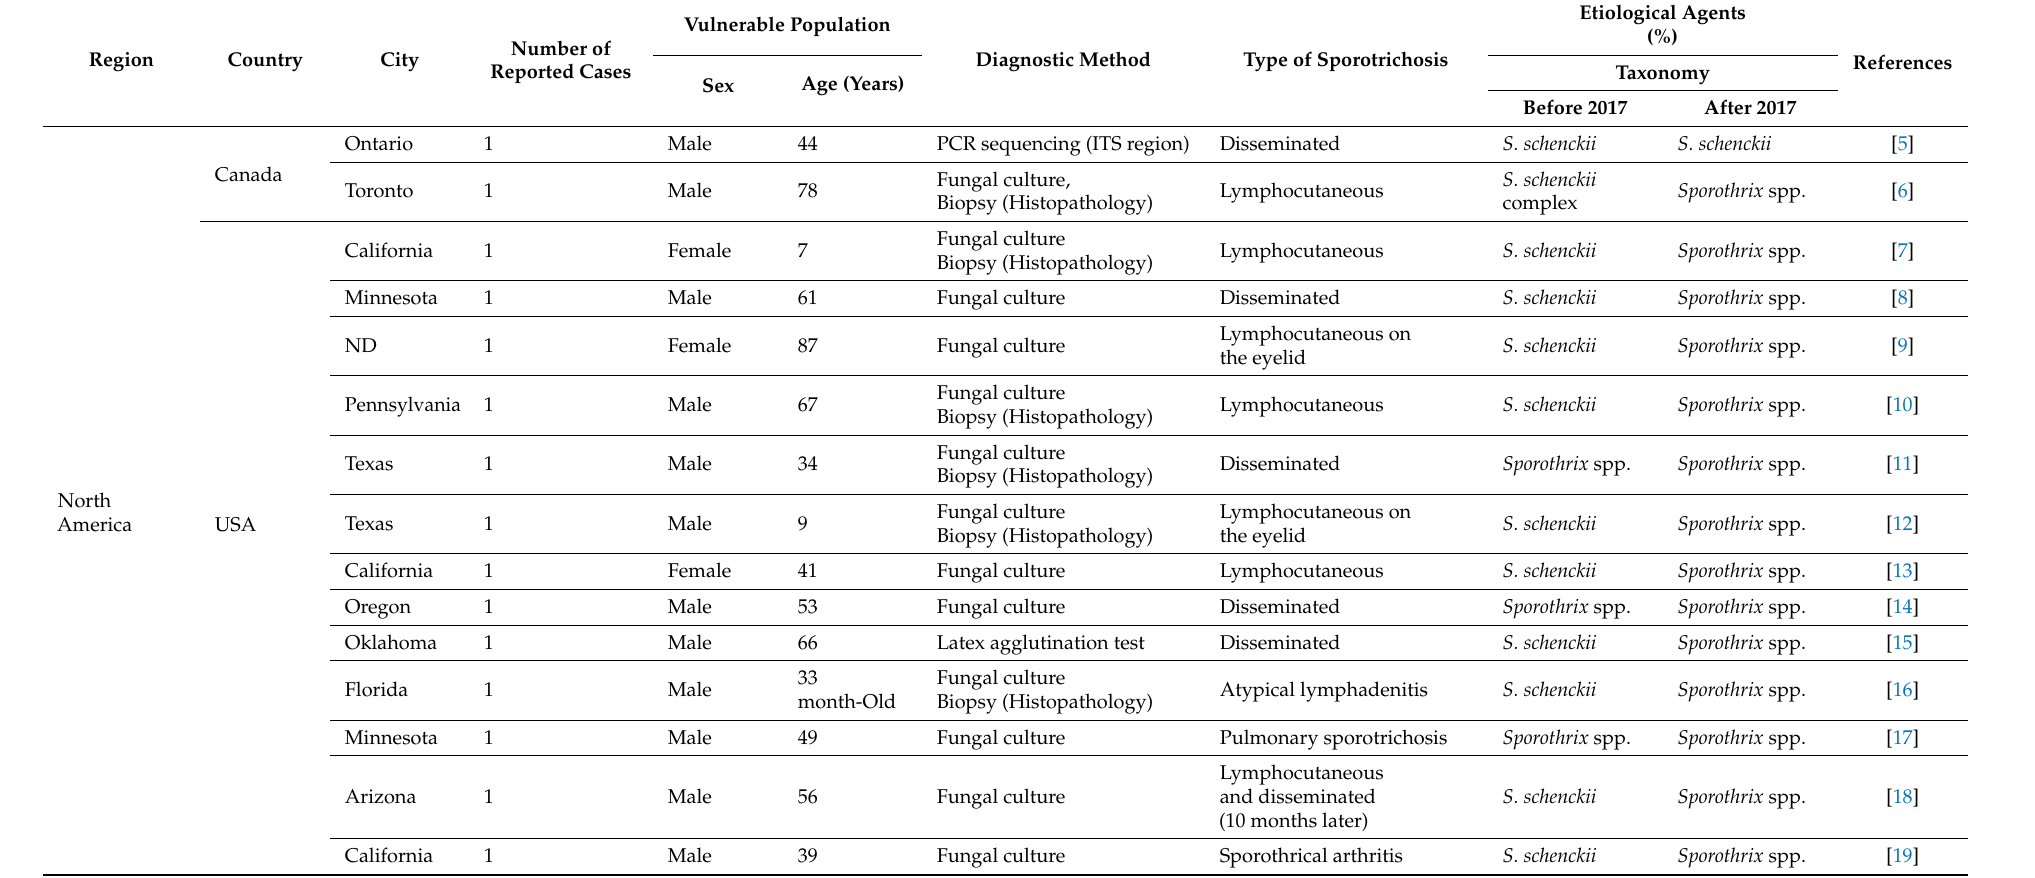
Table 1. Epidemiology of Sporotrichosis in North